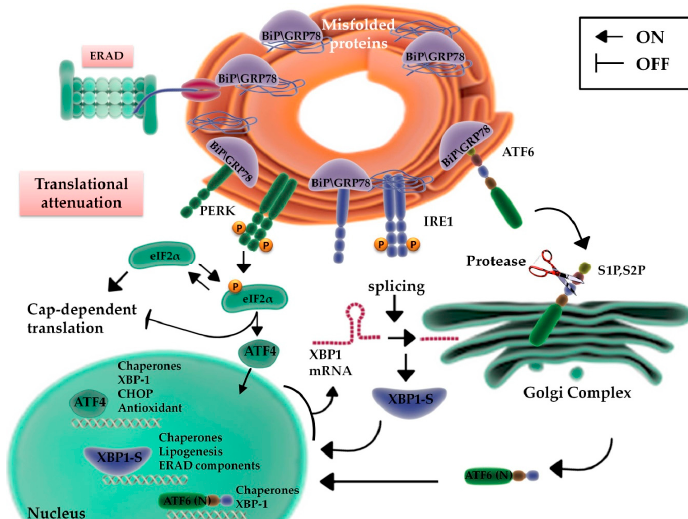
Figure 1. Unfolded protein response activation during Endoplasmic Reticulum (ER) stress conditions.